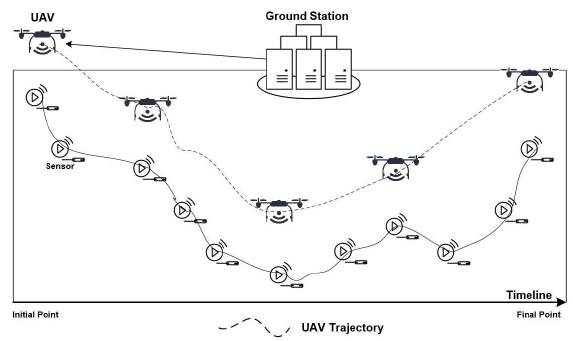
Figure 5. A model of routing UAV for data collection from sensor networks.